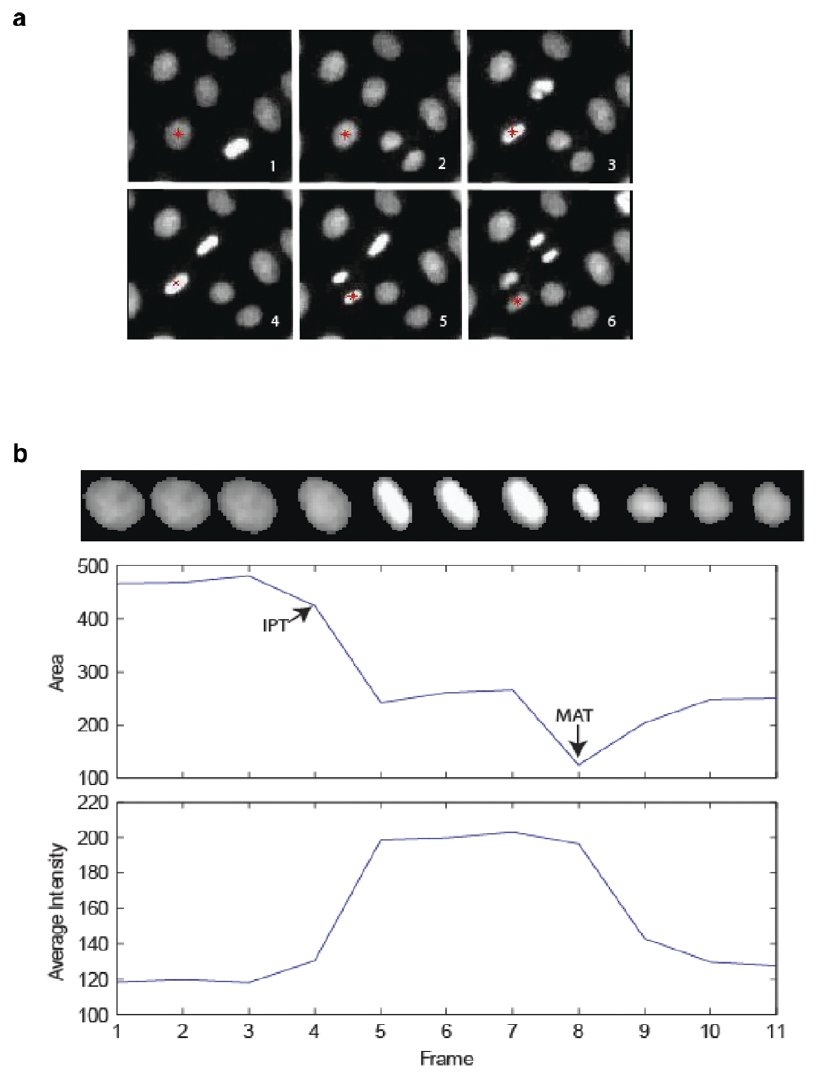
Figure 1. ‘Area’ and ‘Average Intensity’ features are sufficient to identify the boundaries of mitosis. (a) A portion of an image of HeLa cells expressing the fluorescent marker H2B-GFP is shown. The red asterisk marks an example of a nucleus automatically tracked throughout a division. Images were acquired every 12 minutes. At the time of division (between frames 4 and 5) each daughter nucleus is tracked independently to produce a ‘‘trace’’ for the division. The images of the trace are then used for the time-series analysis as shown in (b). (b) An example of a trace, showing the values of average intensity ( I ) and area ( A ) graphed over time with montage of nucleus images. The interphase-prophase transition (IPT) and metaphase-anaphase transition (MAT) points are